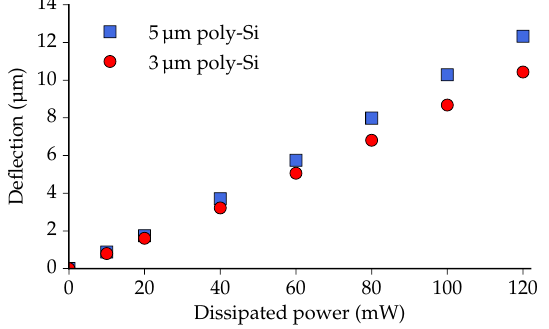
Figure 13. The vertical deflection of the center of the crossbar as a function of the power dissipated in the two